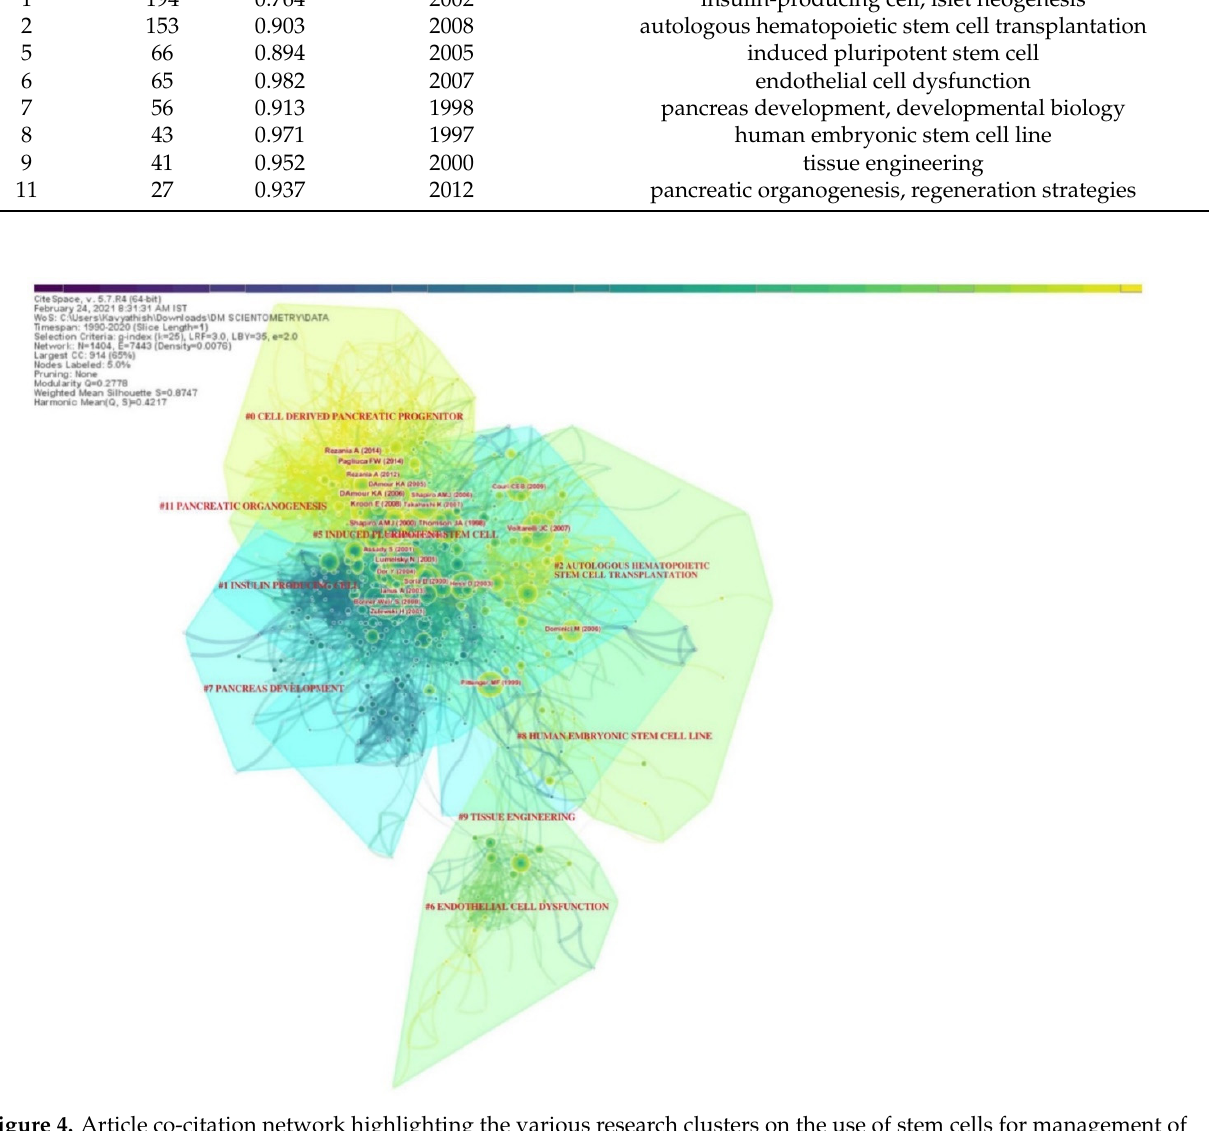
Figure 4. Article co-citation network highlighting the various research clusters on the use of stem cells for management of diabetes mellitus and their research interactions.